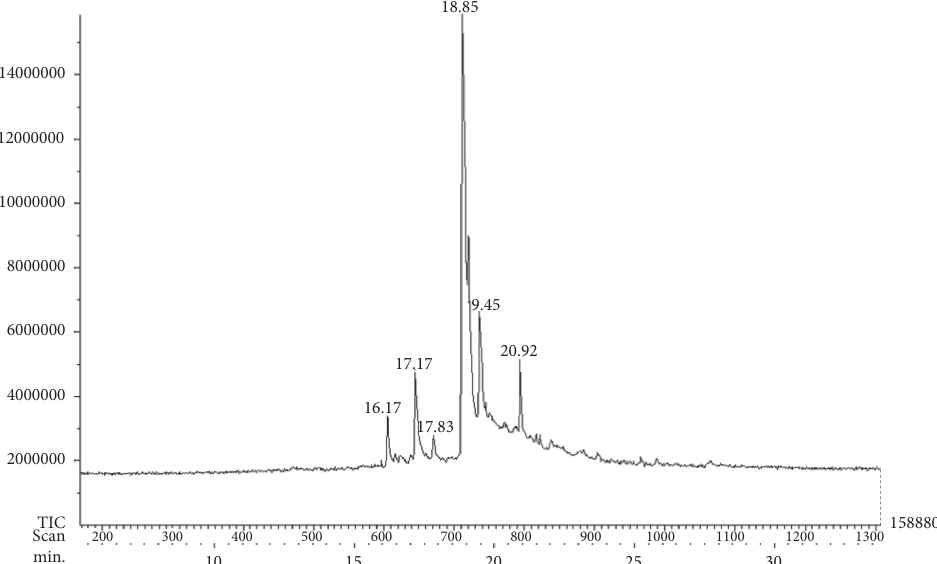
Figure 12: GC-MS chromatogram of metabolites formed after degradation of mixed azo dyes postsequential anaerobic-aerobic treatment in An-SBR and